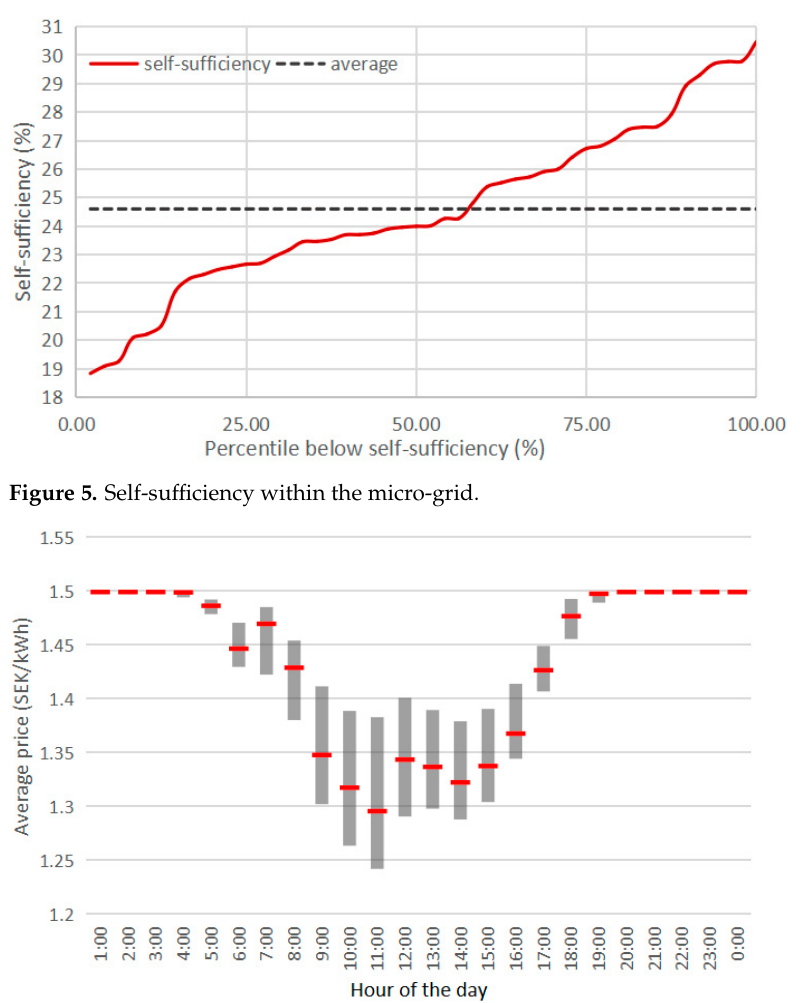
Figure 6. Average price for each hour of the day and its variability within the district (Scenario 1).